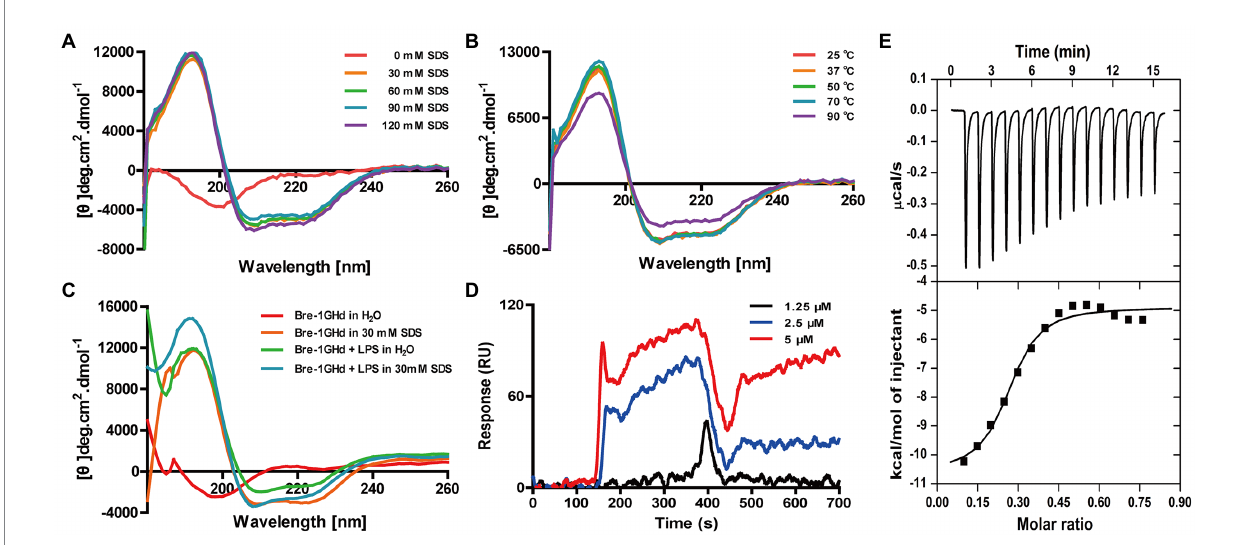
FIGURE 2 CD analysis of Brevinin-1GHd and binding reaction of Brevinin-1GHd with LPS. (A–C) The CD spectra of Brevinin-1GHd in different conditions. (D) Representative SPRi sensorgrams of LPS binding to Brevinin-1GHd immobilized on a gold chip. The black, blue, and red lines indicate the SPRi signal generated by 1.25, 2.5, and 5 μ M LPS flowing through Brevini-1GHd immobilized on the chip, respectively. (E) ITC measurement of Brevinin-1GHd binding to LPS. The top and low panels display thermo changes of each administration and enthalpy changes as a function of ligand/target molar ratio,